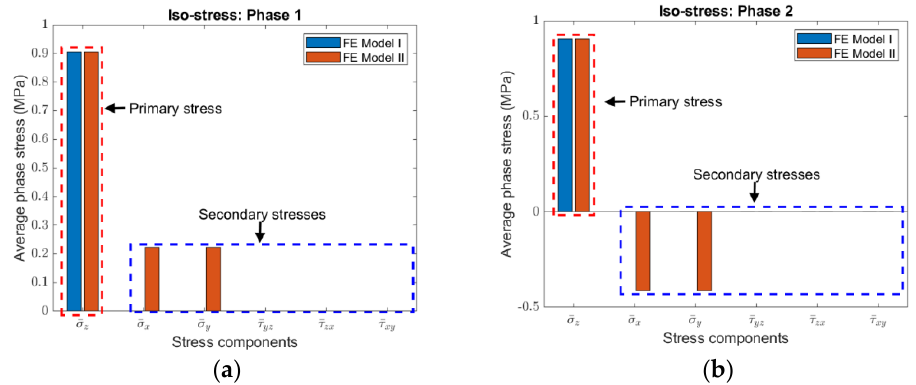
Figure 4. Average stresses in ( a ) Phase 1 and ( b ) Phase 2 of Composite #2 under the iso-stress condition (The volume fraction Phase 2 is 0.35).